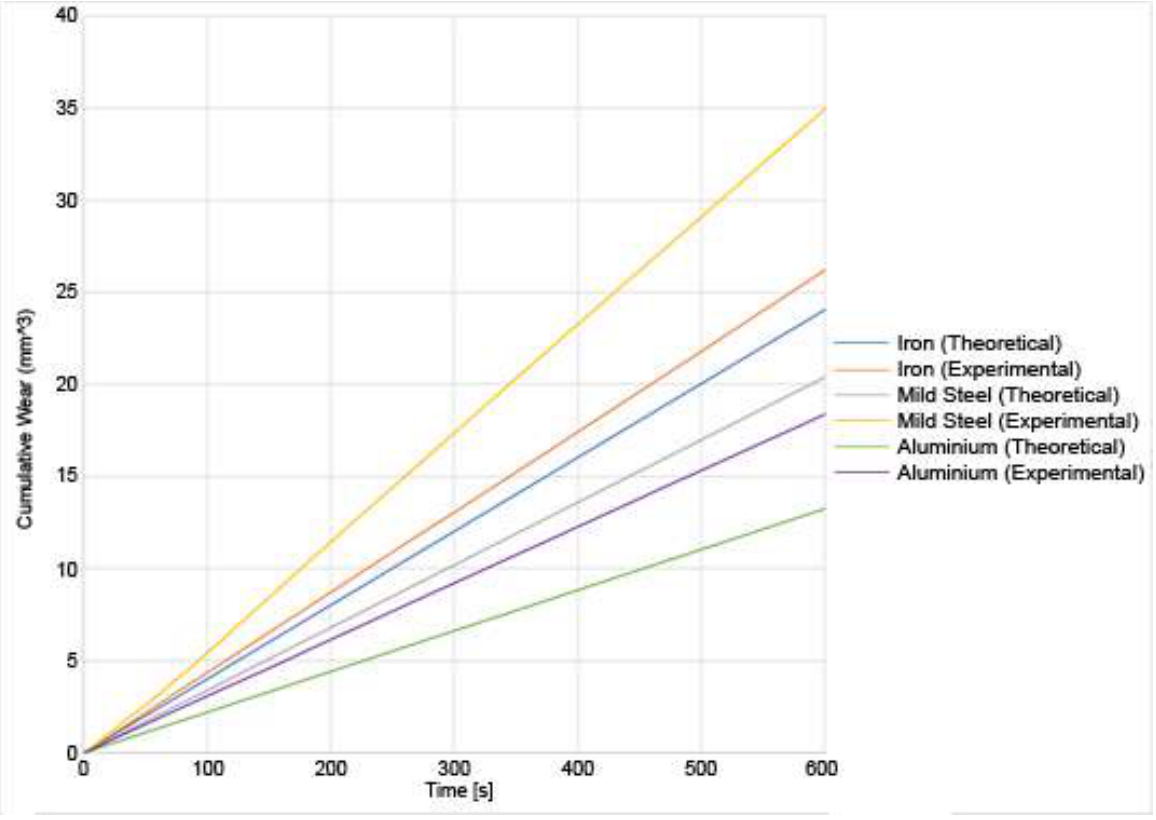
Materials 2021 , 14 , 7308 Figure 13. Experimental and theoretical results for the wear of various materials under a 10 N load.